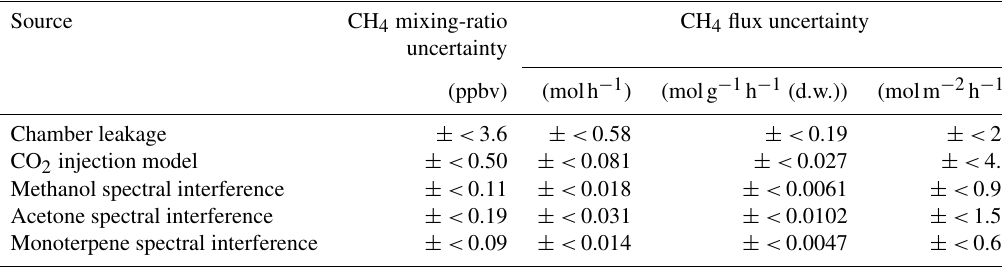
Table 4. Additional sources of uncertainty in CH 4